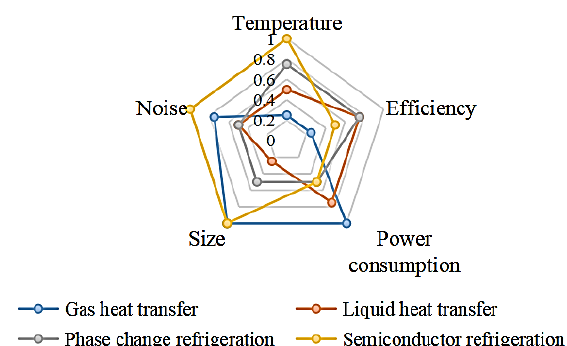
Figure 5. Comparison of different refrigeration methods.